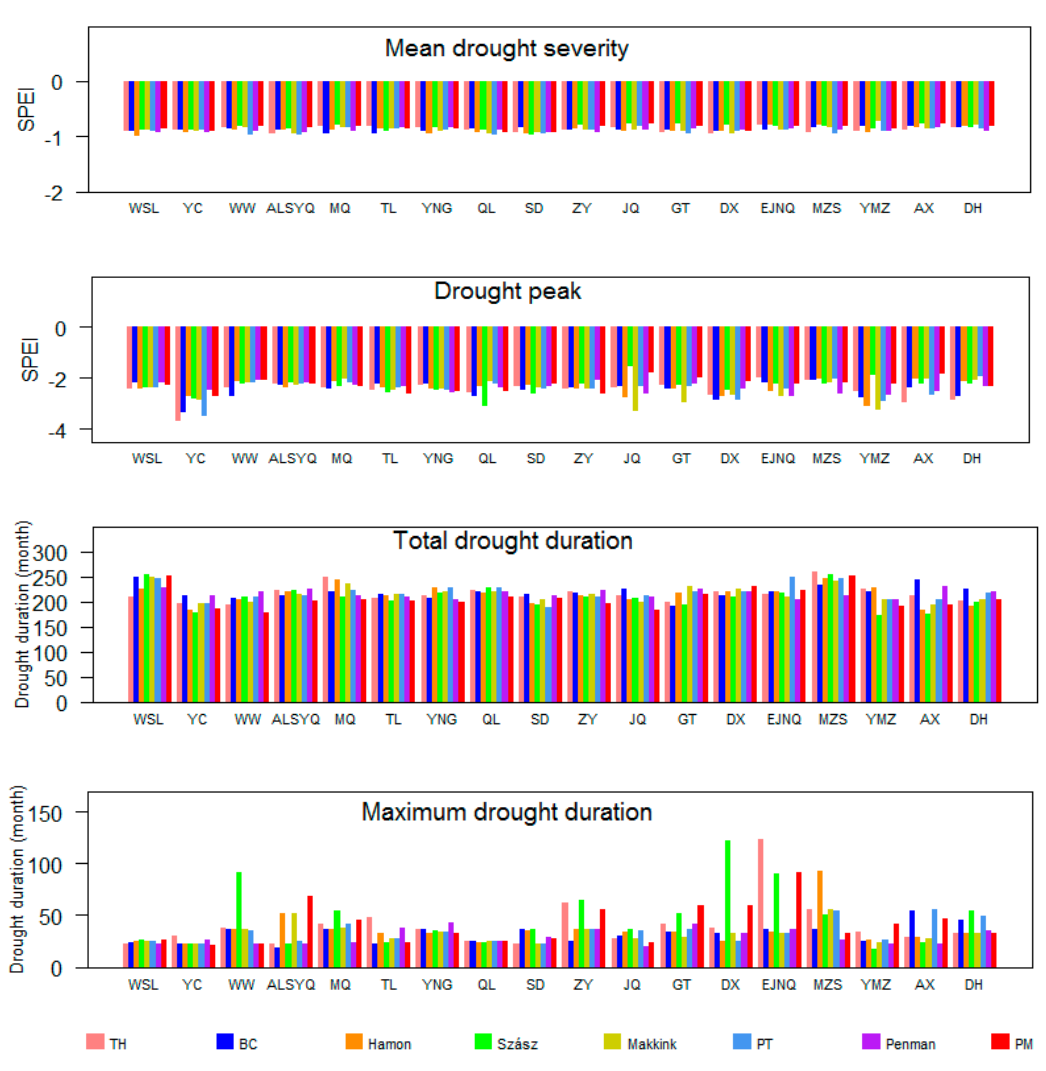
Figure 10. The three drought characteristics obtained from the different SPEI series.